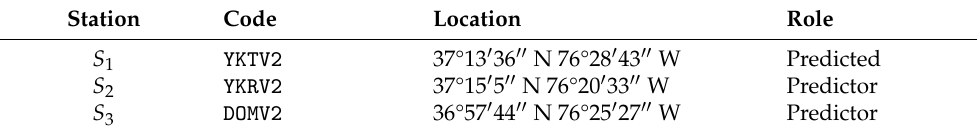
Table 1. Meteorological stations.